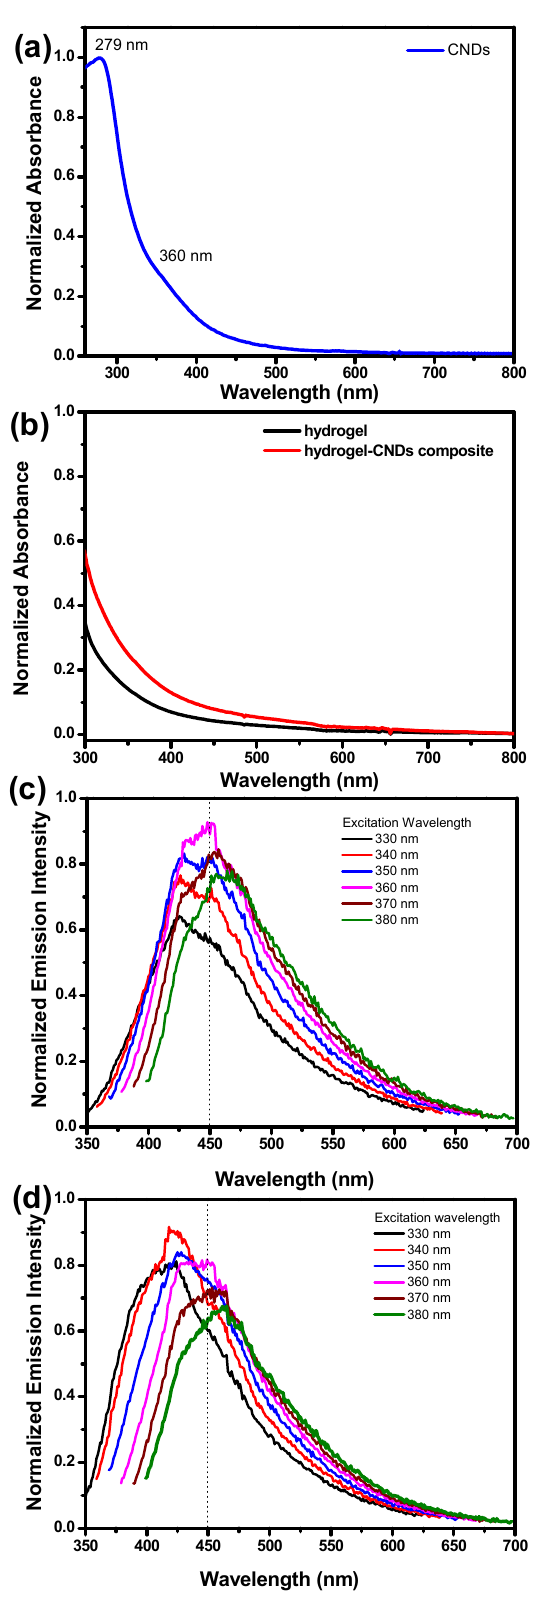
Figure 4. ( a ) UV-Vis absorbance spectrum of the CNDs in aqueous solution; ( b ) UV-Vis absorbance spectra of hydrogel and hydrogel–CNDs composite; ( c ) emission spectra of the CNDs in aqueous solution; ( d ) emission spectra of the hydrogel–CNDs composite.